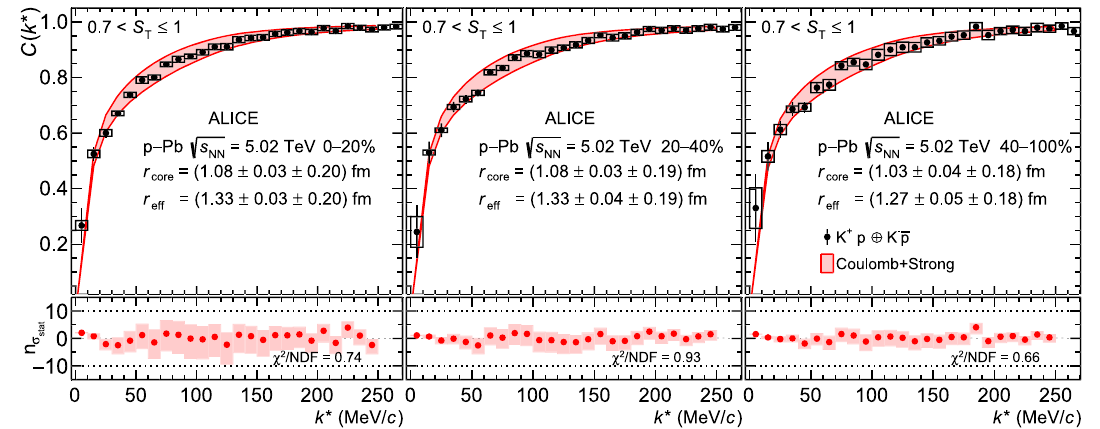
Fig. 2 K + p (K + p ⊕ K − p) correlation functions obtained in p–Pb col- √ s NN = 5 . 02 TeV in the 0–20% (left), 20–40% (middle) lisions at and 40–100% (right) centrality intervals. The measurement is shown by the black markers. The vertical error bars and the boxes represent the statistical and systematic uncertainties, respectively. The red band